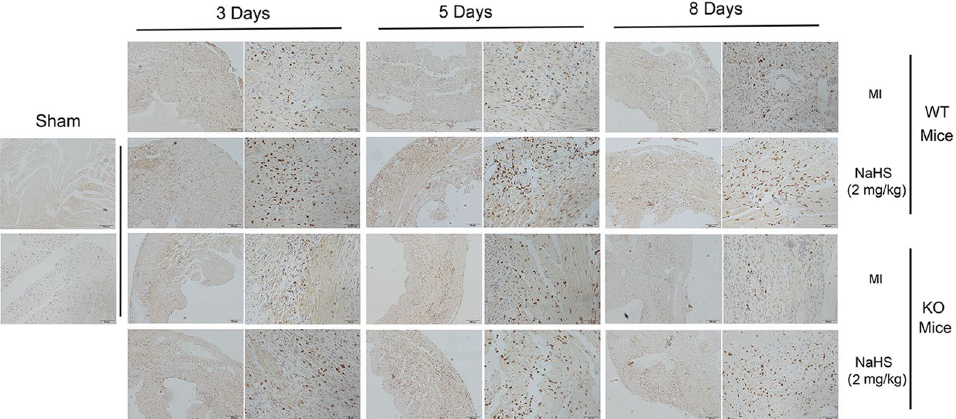
Figure 1. Myocardial immunostaining of CD68 after 3, 5, or 8 days of post-MI treatment with NaHS in both WT and KO mice. Scale bars, 200 μm and 500 μm.